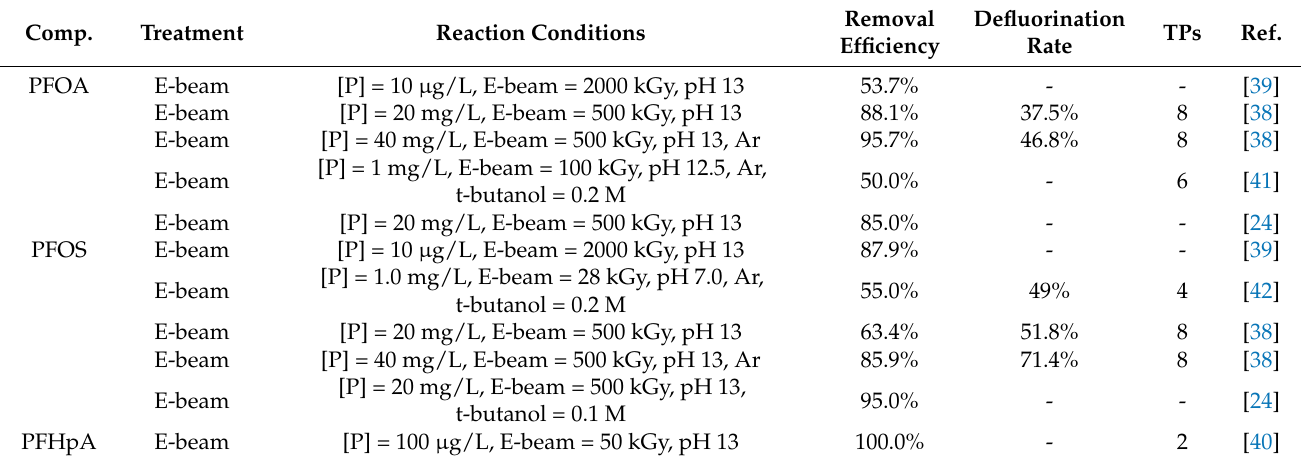
Table 1. The removal–defluorination efficiency and TP formation of PFASs after electron beam irradiation in